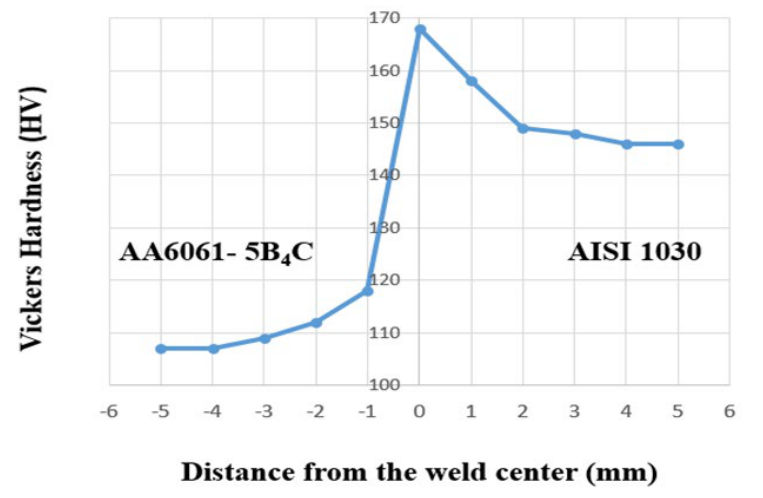
Figure 6. Microhardness distribution of AA6061 - 5%B 4 C/AISI 1030 friction welded joint processed under normal conditions.